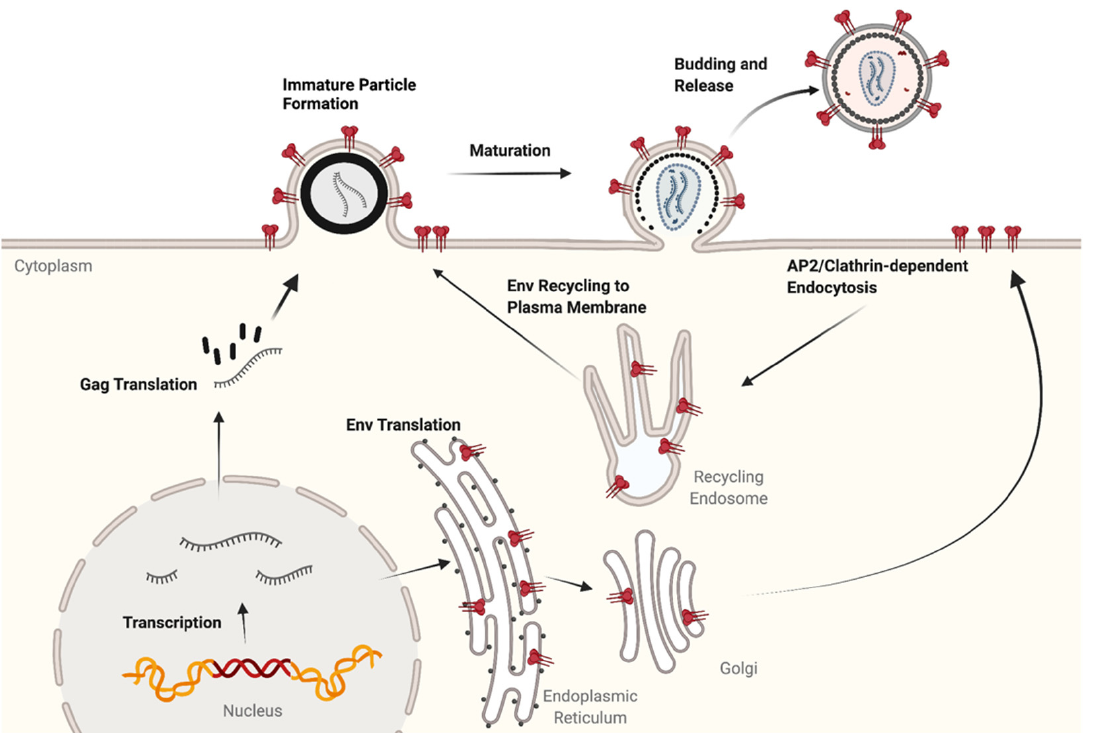
Figure 1. Schematic overview of HIV-1 assembly process. Gag and Env traffic via different routes to reach a common site of assembly on the PM. The path taken by Gag to reach the PM remains uncertain. Env travels through the secretory pathway to the PM, and then is rapidly endocytosed. Depicted here is a role for the recycling endosome in the outward movement of Env to the site of particle assembly. Following the assembly of the immature virion and packaging of the viral gRNA, cleavage of Gag occurs, leading to dramatic structural rearrangements and the formation of the mature virion. Adapted from HIV Replication Cycle by BioRender.com (2022).